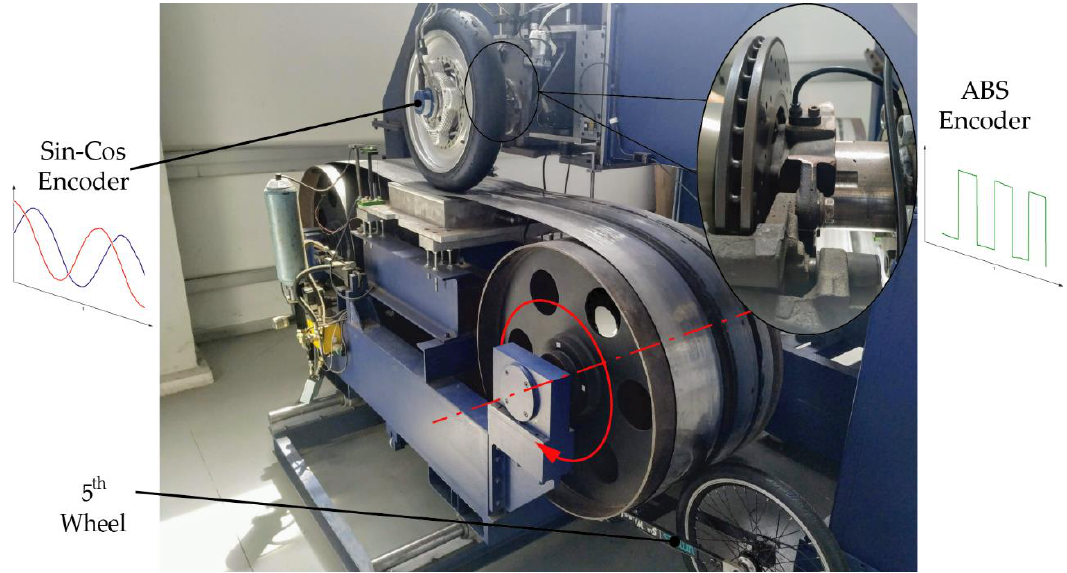
Figure 11. IMMa Flat track with speed sensors depicted. Figure 12. Incremental magnetic encoder, also known as ABS encoder (SKF VKBA 6634). A sbRIO-9637 Single-Board Controller by National Instruments™ was used to per- form data acquisition. This device includes an FPGA and a real-time operating system. To avoid possible asymmetries in the output signal of the Hall effect sensor, the rising edges provided by the incremental encoder were used to measure the angular speed. Equation